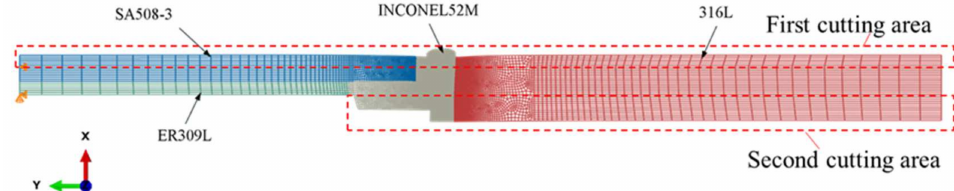
Figure 7. Model geometry and meshing used for the modelling analysis of the final machining process (in the current coordinate system, x, y and z respectively represents the radial, axial and hoop direction of the tube, which also applies to all the other FE contour plots in this